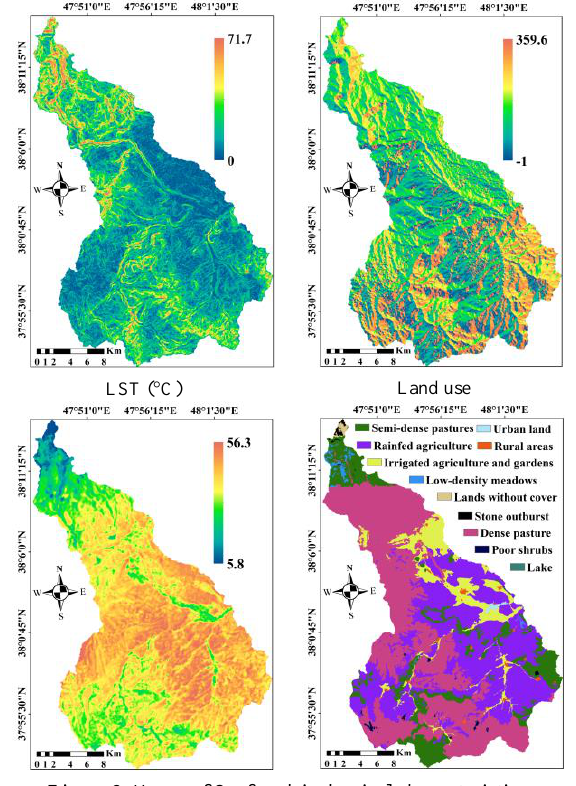
Figure 3. Maps of Surface biophysical characteristics, topographical parameters and land use of the study area on 01/07/2018. The surface biophysical characteristics and topographical parameters of the study area are heterogeneous. The relationship between DEM and LST is inverse due to the effect of NSTLR. The LST decreased with the increase of elevation (He et al. 2018; Jain et al. 2008; Lakshmi et al. 2001; Zhang et al. 2018). The results for different dates are shown in Table 1.